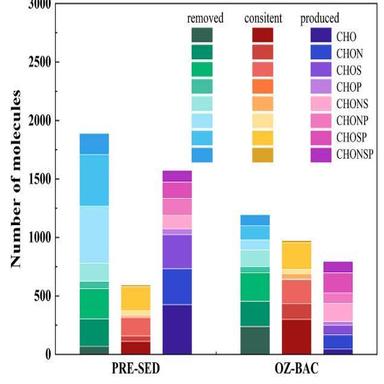
Dynamics of DOM in drinking water treatments including pre-ozonation and coagulation-sedimentation, and ozonation-BAC.